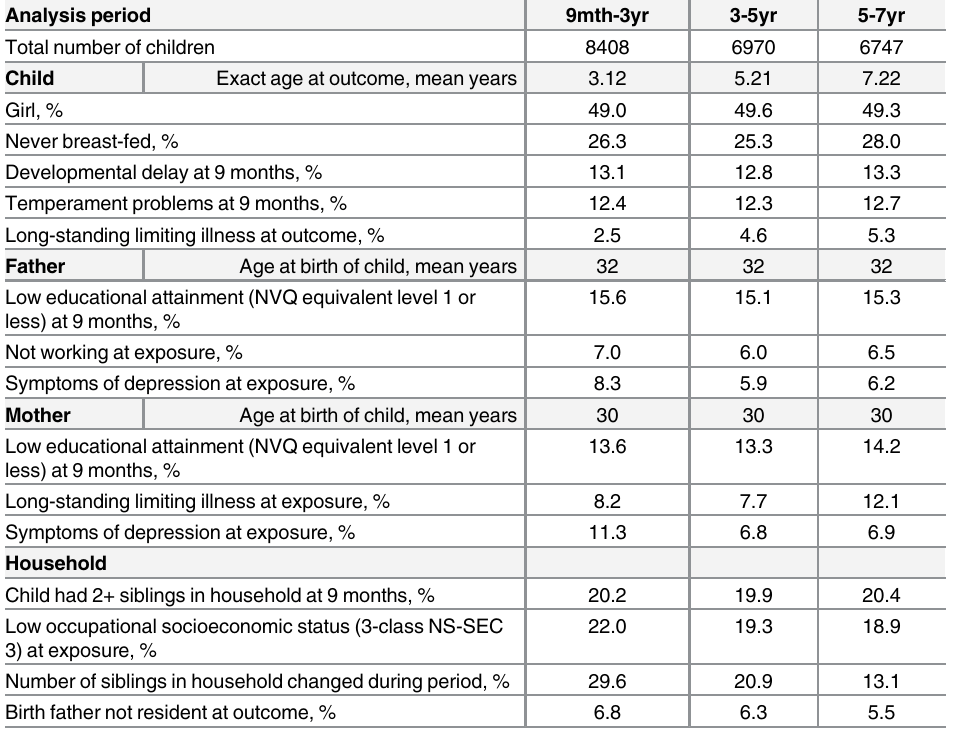
Table 4. Characteristics of study